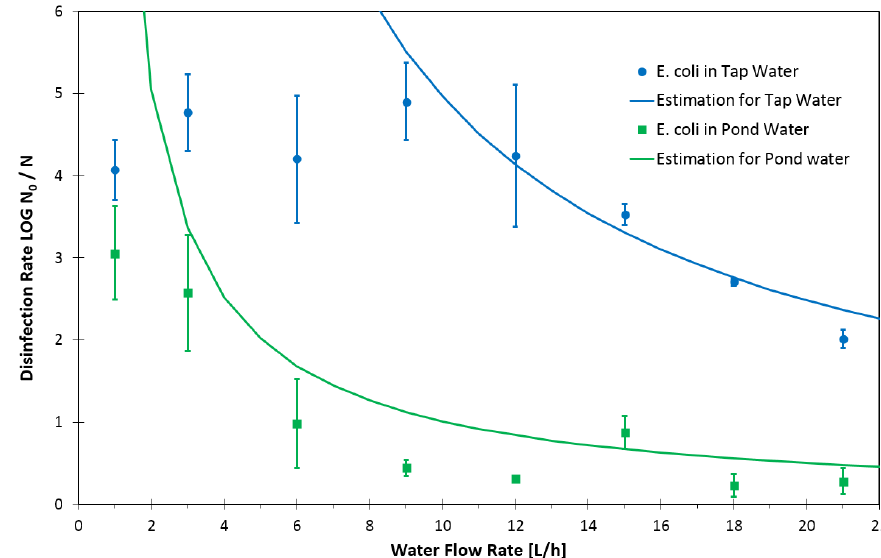
Figure 3. Relative E. coli reduction by the 285 nm LED radiation behind the quartz tube. The symbols mark measured values with error bars that show the standard deviation. The continuous curves are estimated by a simplified model.